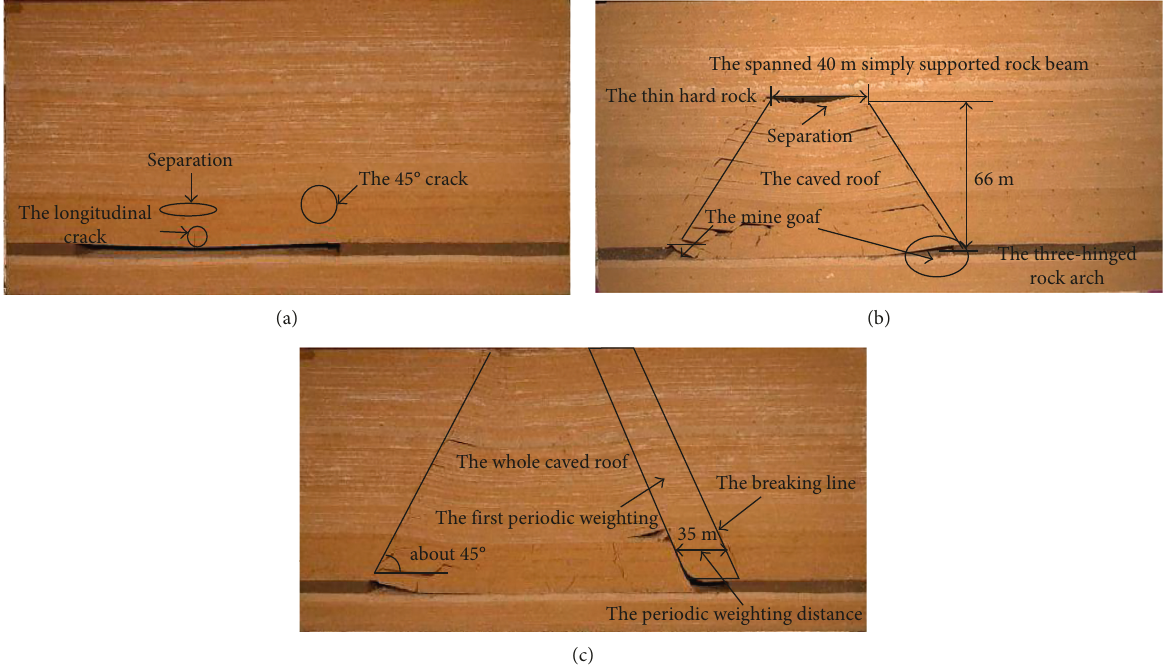
Figure 3: The failure forms of the overlying strata and crack development characteristics during excavation. The coal stratum is excavated to (a) 120 m, (b) 130m, and (c)